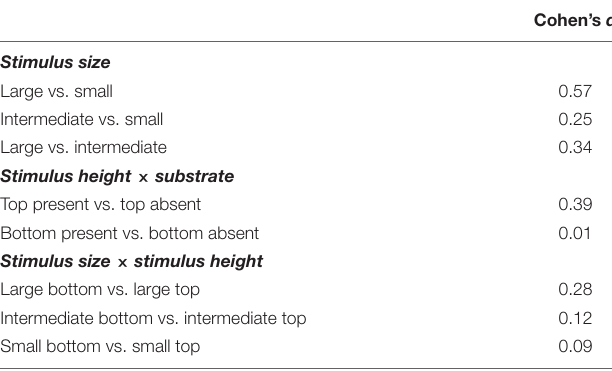
TABLE 2 | Effect sizes for the pairwise comparisons associated with the significant independent factors reported in the study.